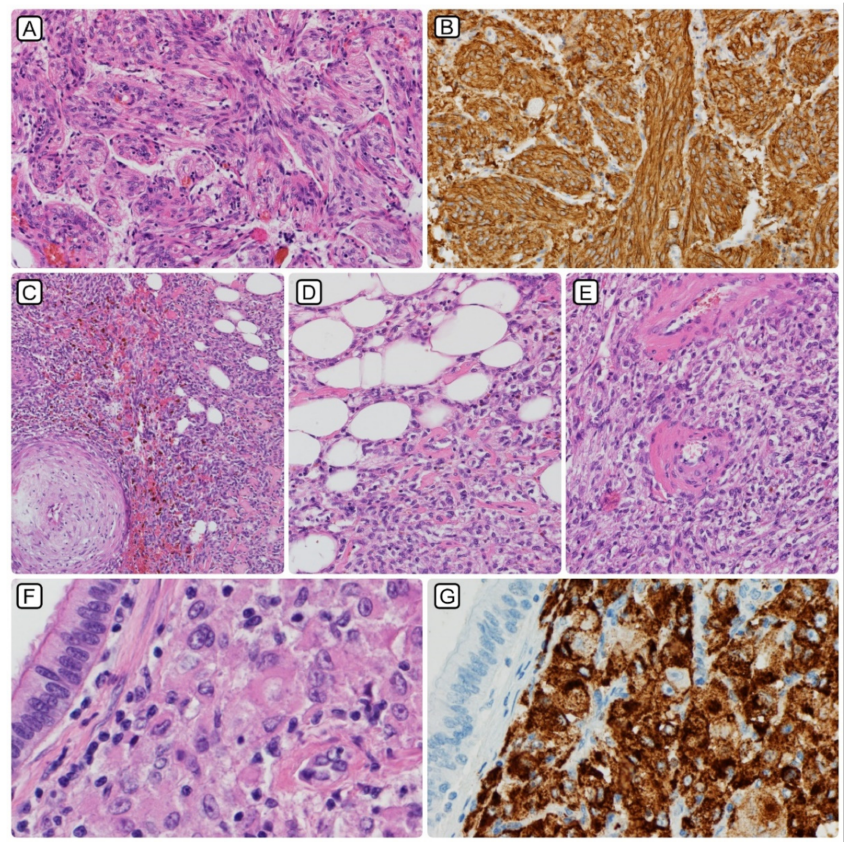
Figure 3. Histopathological spectrum of PEComa; retroperitoneal LAM: ( A )—HE (200 × ); ( B )—SMA (200 × ). AML: ( C )—classical presentation with a mixture of spindle cell component, thick, hyalinizing vessels, and mature adipose tissue (100 × ), ( D )—mature adipose tissue and fibrous stroma (200 × ), ( E )—thick, hyalinizing vessels (200 × ); PEComa, NOS: ( F )—PEComa metastasis to the lung, where the bronchial epithelium is seen in the upper left corner (400 × ), ( G )—PEComa metastasis in HMB-45 immunostaining (400 × ). Table 1. The clinical course of the disease of patients treated surgically for PEComa exclusively at the reference sarcoma center.